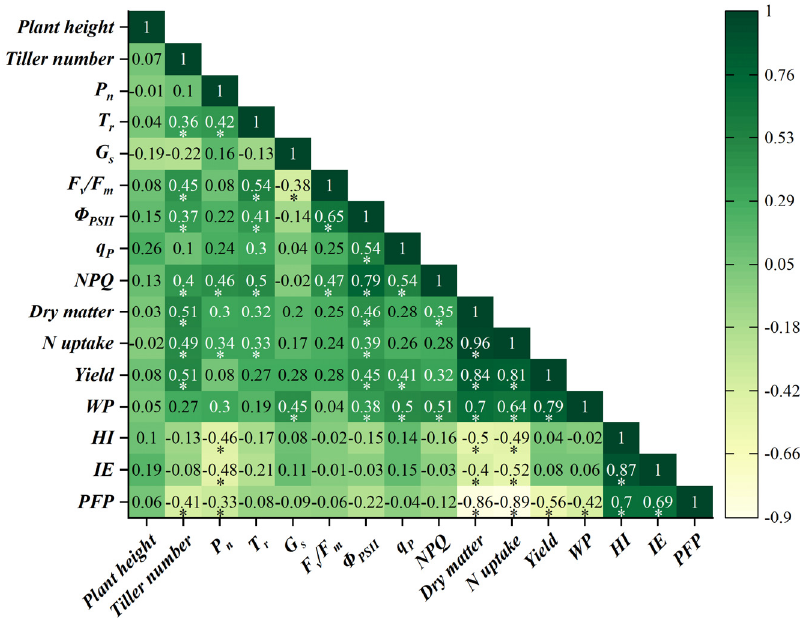
Figure 8. Correlation analysis between morphological and photosynthetic characteristics, biomass and N accumulation, yield and efficiency indices based on two years of rice experiments. Numbers and * in the boxes indicate the Pearson correlation coefficients and statistical significance ( p <